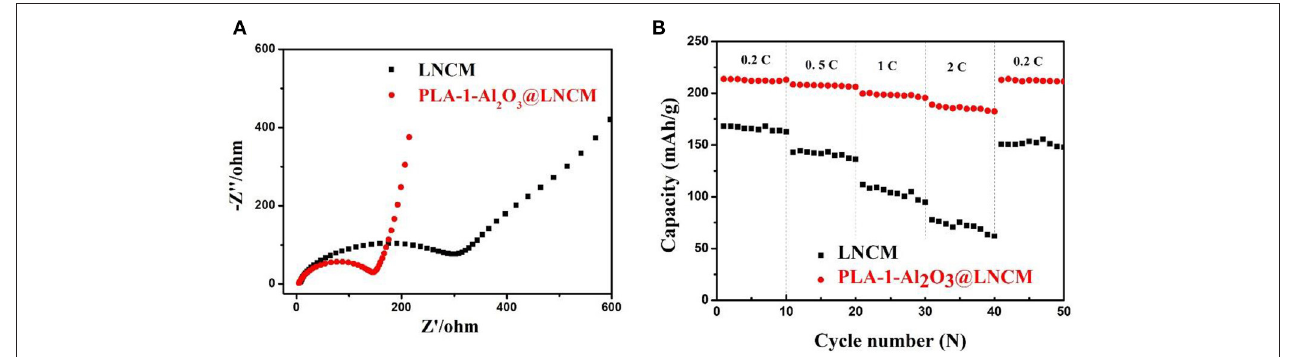
FIGURE 6 | (A) Nyquist plots of bare LNCM and PLA-1-Al 2 O 3 @LNCM. (B) Rate capabilities vs. cycle number for bare LNCM and PLA-1-Al 2 O 3 @LNCM electrodes cycled at 0.2, 0.5, 1, 2, 0.2 ◦ C rates between voltage limits of 2.8 and 4.3V.